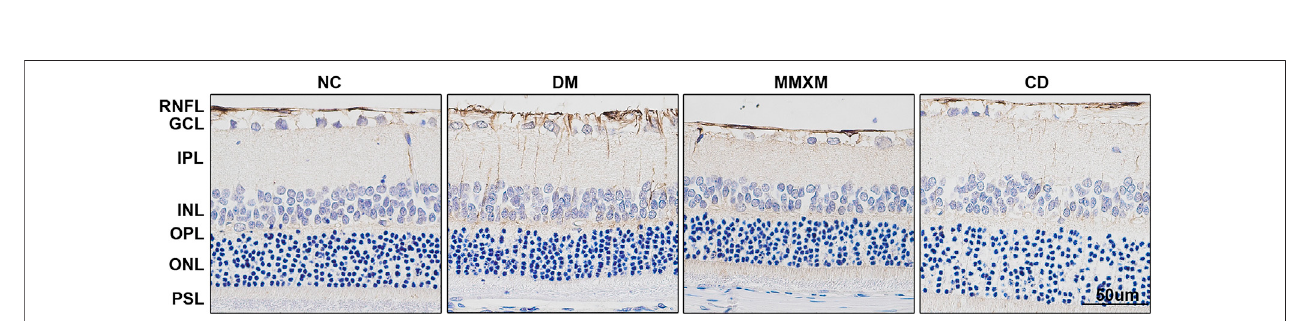
FIGURE4| GFAPexpressionofretinalMüllercellsbyimmunohistochemistry.GCL,ganglioncelllayer;INL,innernuclearlayer;IPL,innerplexiformlayer;OPL,outer plexiform layer; ONL, outer nuclear layer; PSL, photoreceptor segment layer, RNFL, retinal nerve fi ber layer. Original magni fi cation 400 × . Positive cells were stained brownish yellow. Scale bar: 50 μ m.